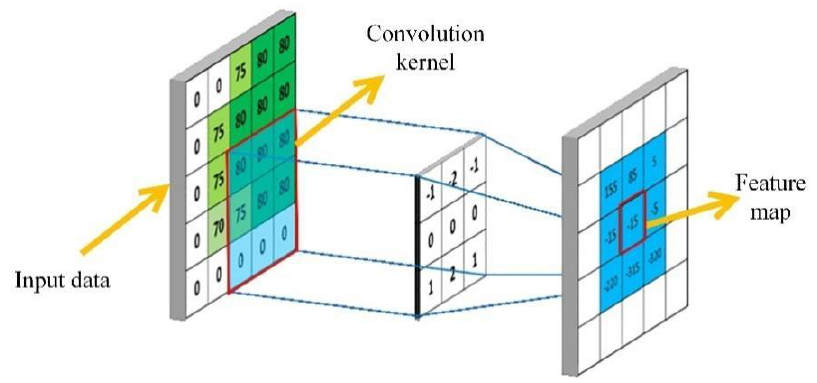
Figure 2. The schematic diagram of the convolution process.